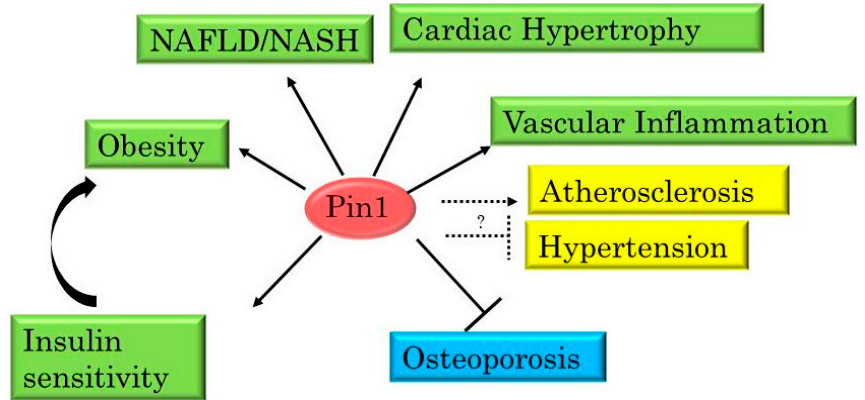
Figure 3. Pin1 plays important roles in the development of diseases. Pin1 promotes the progression of obesity, cardiac hypertrophy, vascular inflammation and NASH (shown as solid arrows), while suppressing osteoporosis. Pin1 also increases insulin sensitivity in metabolic organs, but this enhancement may be linked to obesity. The roles of Pin1 in atherosclerosis and hypertension are unresolved issues (shown as dotted lines and question mark).